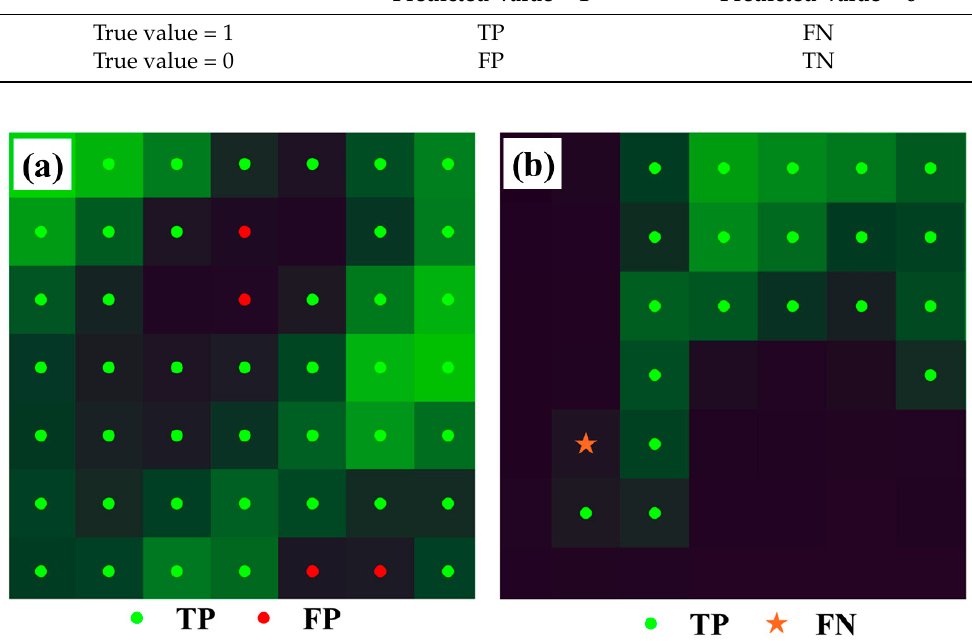
Figure 5. Classification results for TP, FP, FN, and TN, (( a ) is classification results for TP and FP, where the green solid circle represents TP, and the red solid circle represents FP. ( b ) is classification results for TP and FN, where the green solid circle represents TP, and the orange pentagram represents FN).